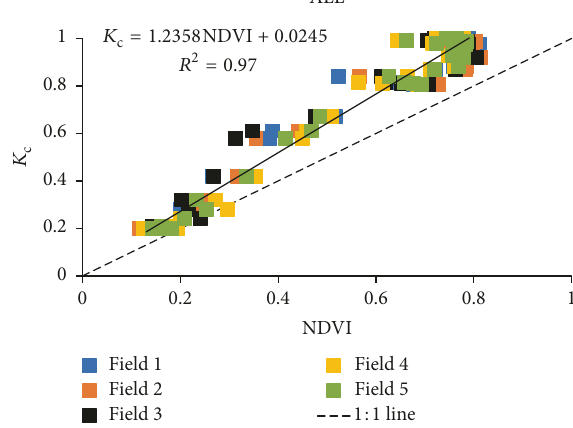
Figure 5: Linear relationship between NDVI and 𝐾 c for all data. The dashed line indicates the 1:1